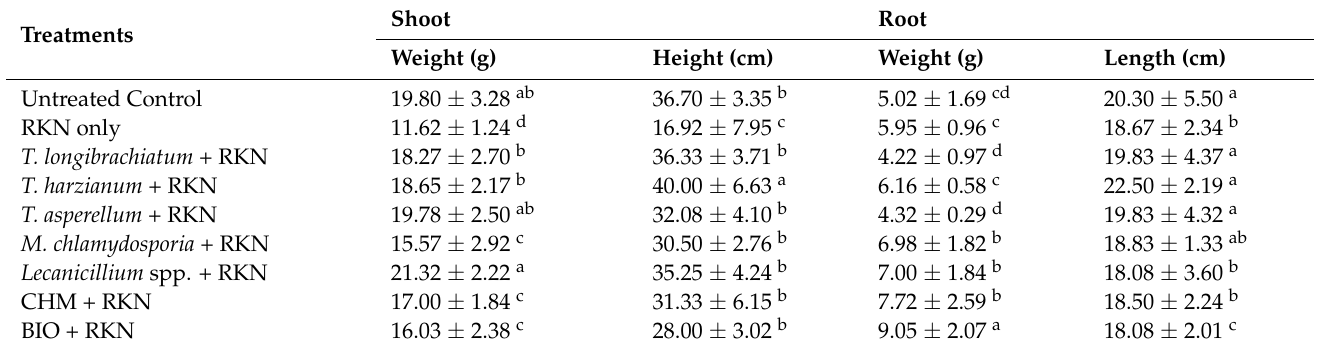
Table 2. Effect of soil treatment by filamentous fungi under investigation, biological and chemical nematicides on tomato growth, 60 days after M. javanica